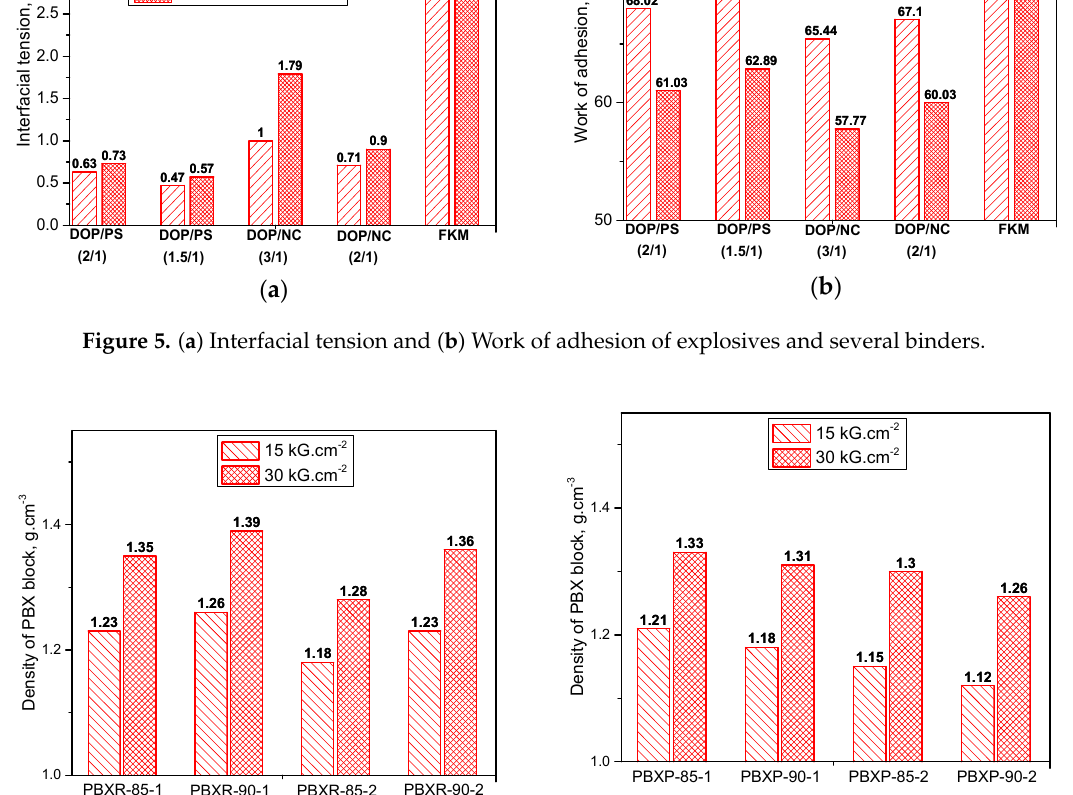
Figure 6. The density of PBX blocks based on RDX ( a ) and PBX blocks based on PETN ( b ) at different compression pressures.